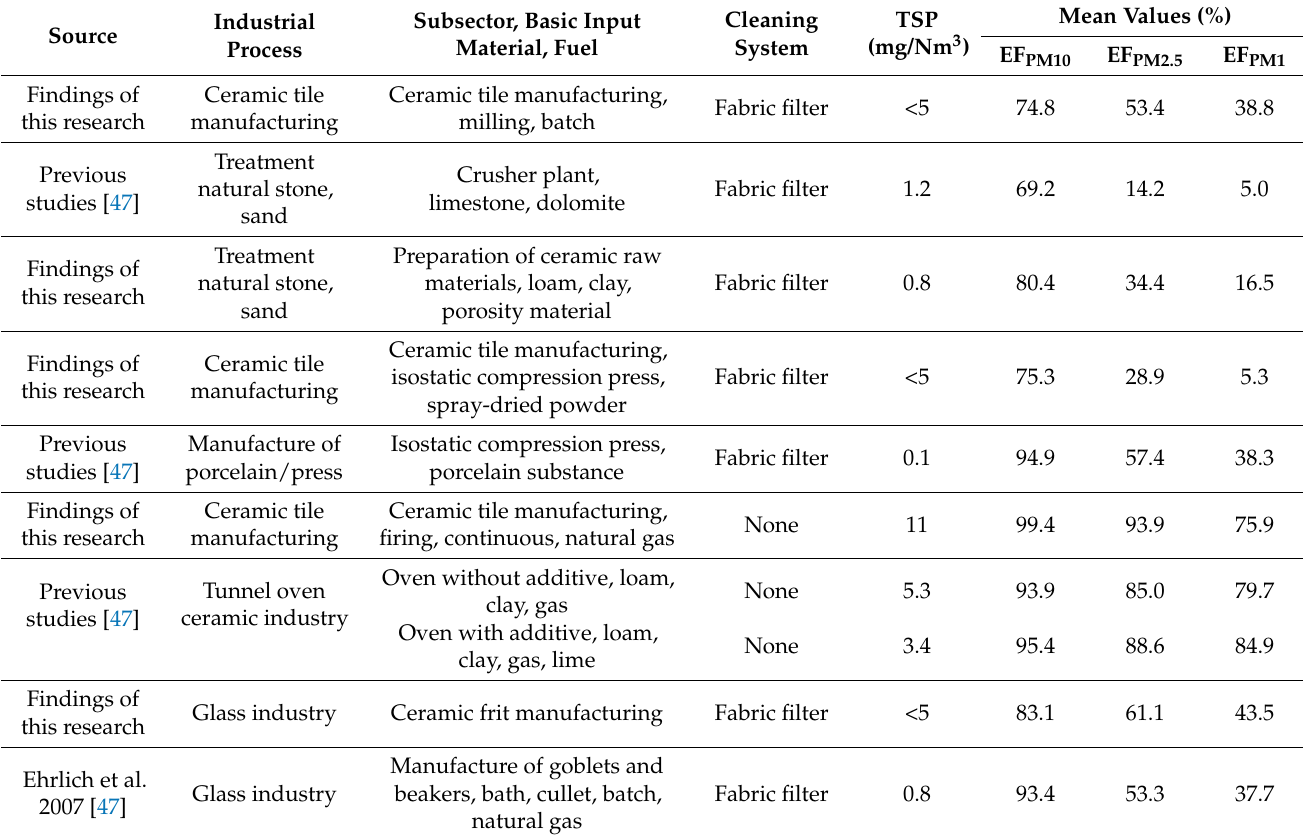
Table 10. Compilation of emission